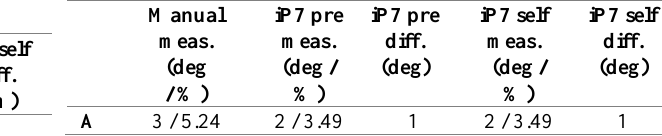
Table 7. Slope of first scenario target of interest using a 3D